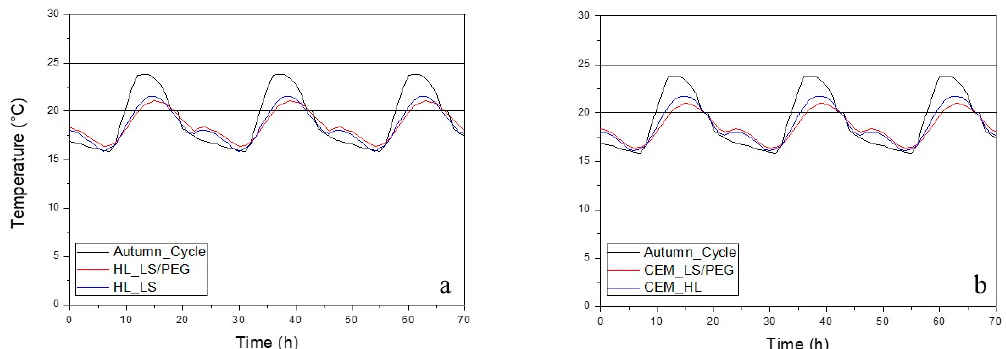
Figure 7. Thermal behavior in autumn of developed mortars: ( a ) hydraulic lime-based mortar and ( b ) cement-based mortar. The thermal comfort zone is between 20–25 °C.